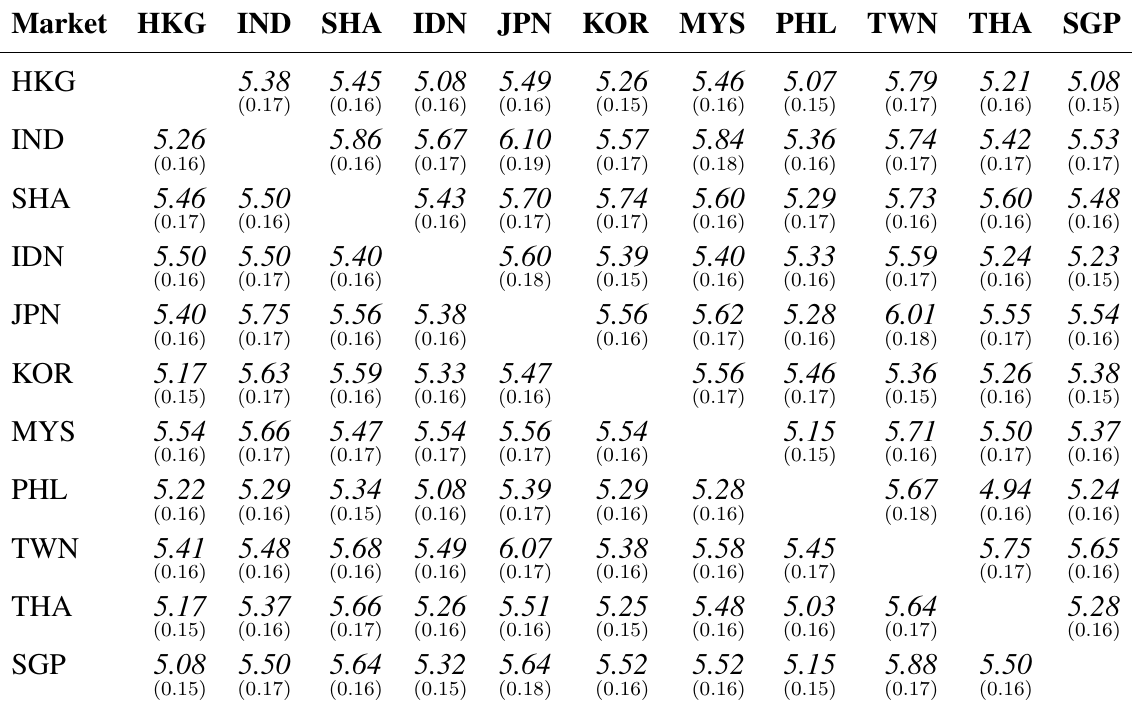
Table 10. Estimation results of ⌘ in the bivariate SV